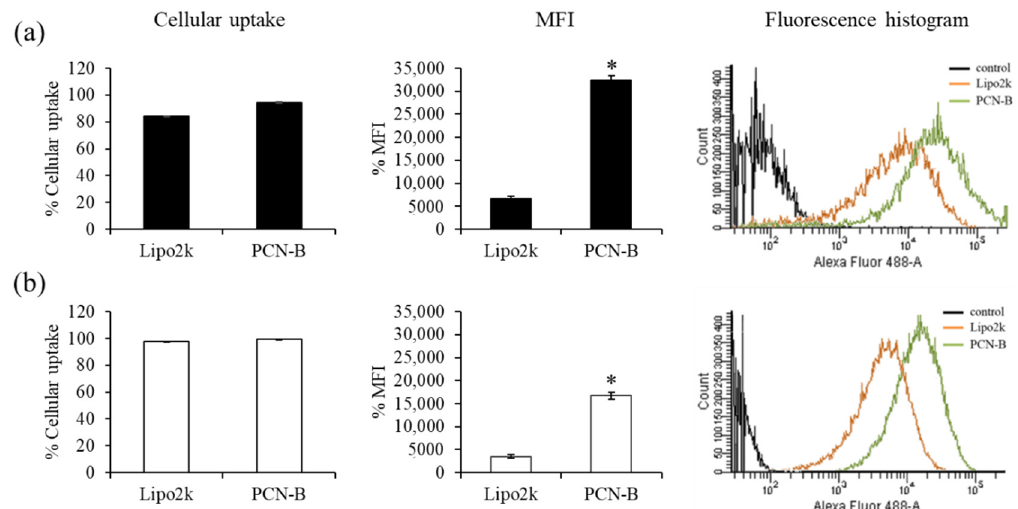
Figure 2. Cellular uptake study of Lipo2k or PCN-B/siAF488 complexes in ( a ) MCF-7 cells and ( b ) MDA-MB-231 cells by flow cytometry. The results were presented as the percentage of cellular uptake, mean fluorescent intensity (MFI) plot, and fluorescence histogram. * p < 0.05.